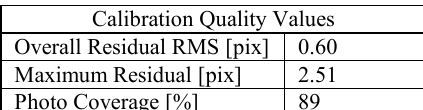
Table 1. Achieved accuracy of RPAS images project